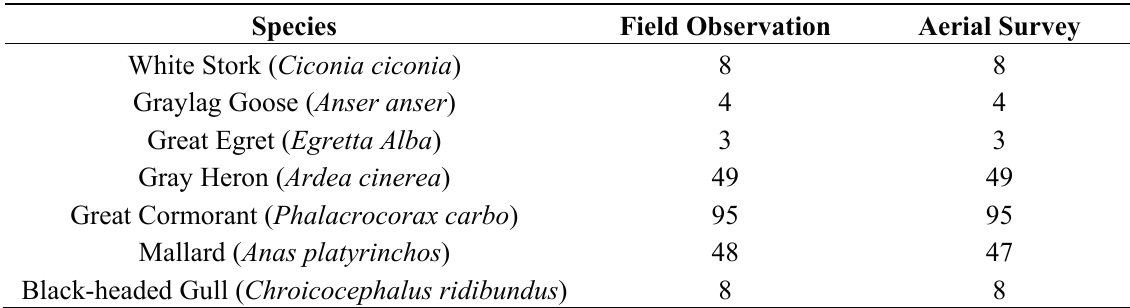
Table 5. Number of individuals in the enclosures and in the foliage that were selected for testing by the Budapest Zoo & Botanical Garden at the time of the overflight based on the field and aerial survey data.